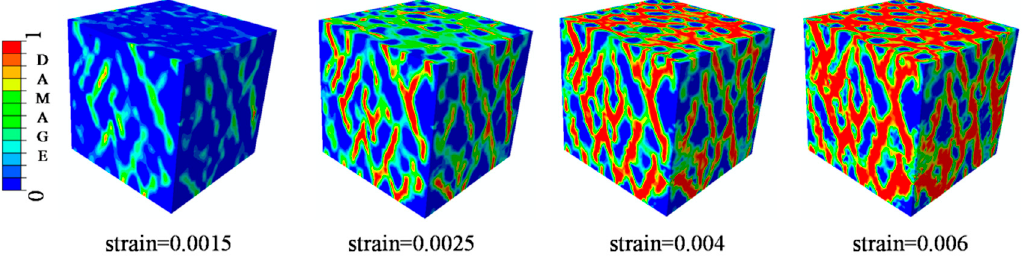
Figure 23. Damage evolution patterns when µ = 0.